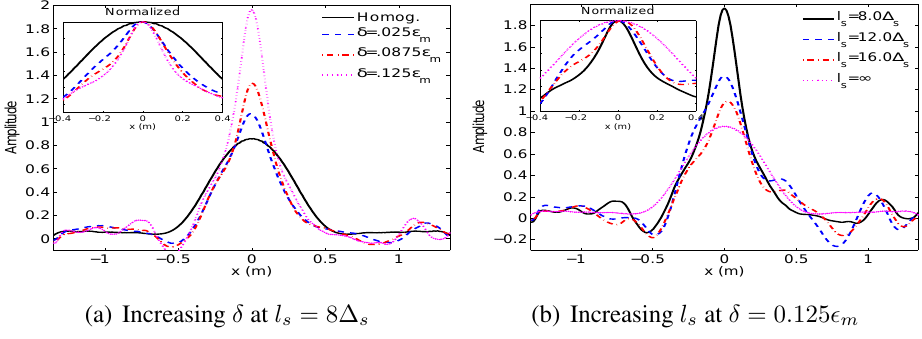
Figure 4. Cross-range resolution for varying (a) 1st and (b) 2nd order medium statistics.